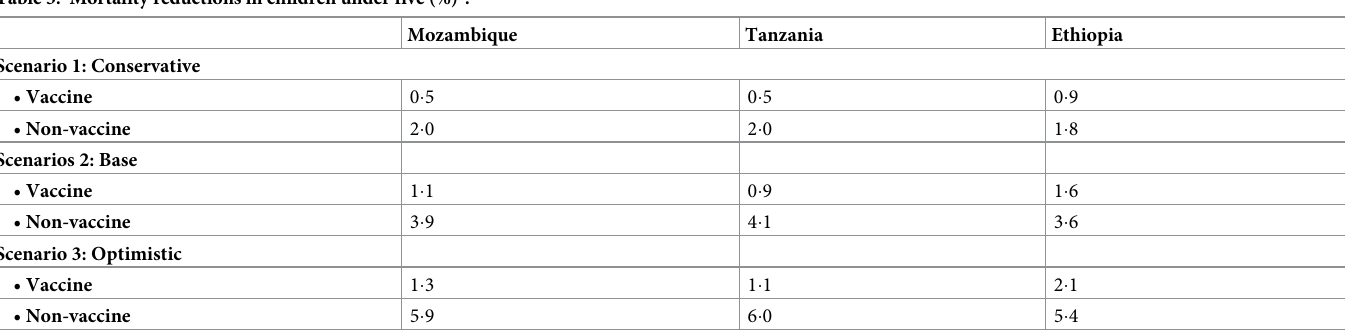
Table 3. Mortality reductions in children under five (%) a .